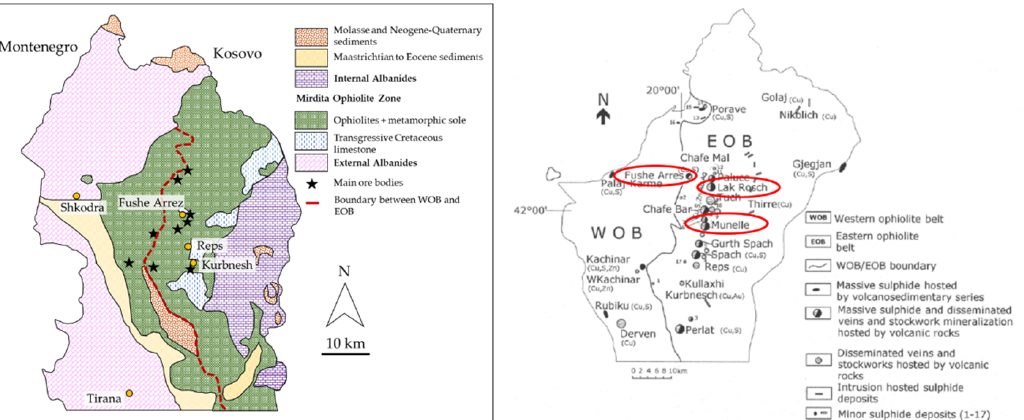
Figure 1. On the left : simplified geological map of the Albanian ophiolites and surrounding units (modified from [29]). The dashed line depicts the approximate boundary between the western- and eastern-type ophiolites. On the right : spatial distribution of major sulfide mineralized bodies in north-central Albanian ophiolites [26], whereas the Fushë Arrëz enrichment plant and the two copper ore mines Munella and Lak Roshi are marked in red